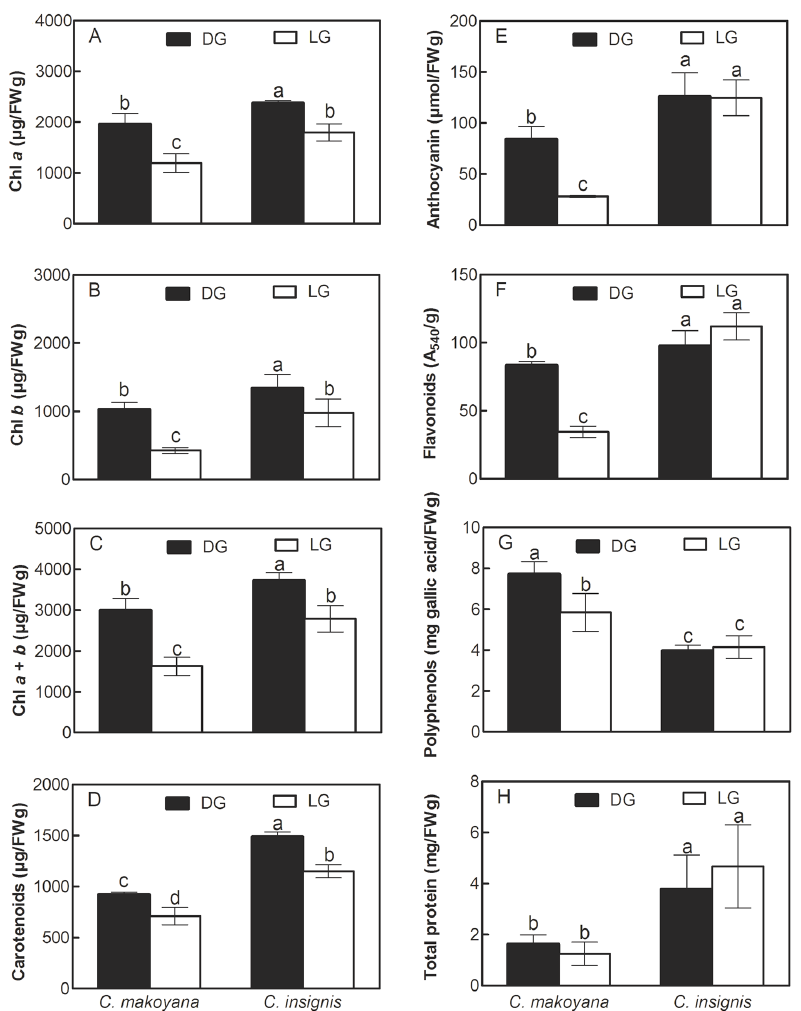
Figure 4. Content of Chl a ( A ), Chl b ( B ), Chl a + b ( C ), Carotenoids (Cars) ( D ), Anthocyanins (Ant) ( E ), Flavonoids (Fla) ( F ), Polyphenol (PP) ( G ), and total protein ( H ) of dark green leaf sector (black bar, DG) and light green leaf sector (white bar, LG) in Calathea makoyana and C. insignis . Vertical bars indicate the standard deviation ( n = 5). Different lowercase letters among levels are significantly different at p ≤ 0.05 by Fisher’s least significant difference (LSD) test.